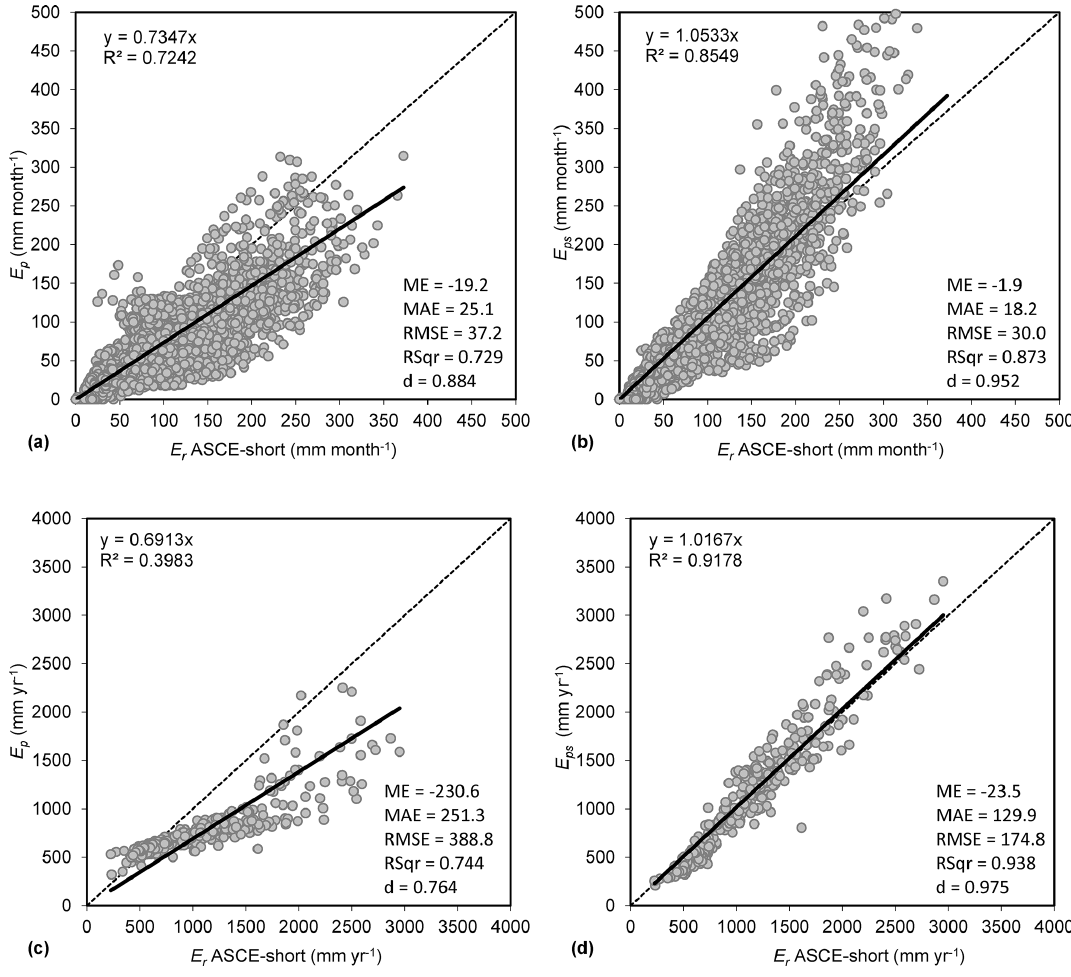
Figure 4. (a) The 1:1 plots of mean monthly E p versus mean monthly E r , (b) mean monthly E ps versus mean monthly E r , (c) mean annual E p versus annual monthly E r , and (d) mean annual E ps versus annual monthly E r , using the data of all 525 stations from the three databases CIMIS, AGBM, and